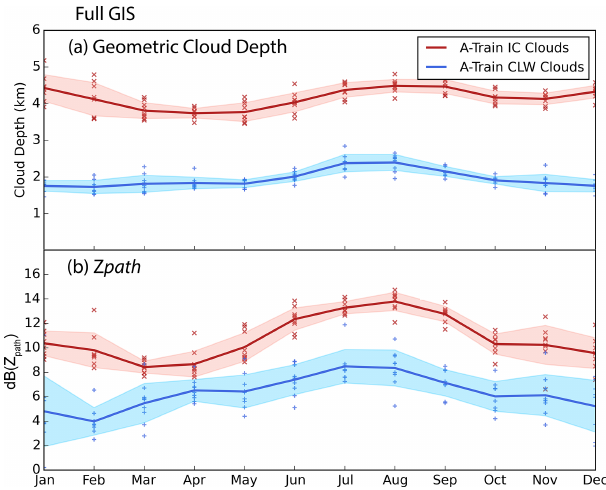
Figure 8. Annual cycle of GrIS snowfall cloud characteristics. (a) The geometric cloud depth and (b) the vertically integrated re- flectivity for IC (red) and CLW (blue) snowfall observations. The solid lines represent the average of all observational years, with each marker ( × , + ) depicting a single year’s monthly average. The shaded region surrounding each line is the standard deviation about the mean for the